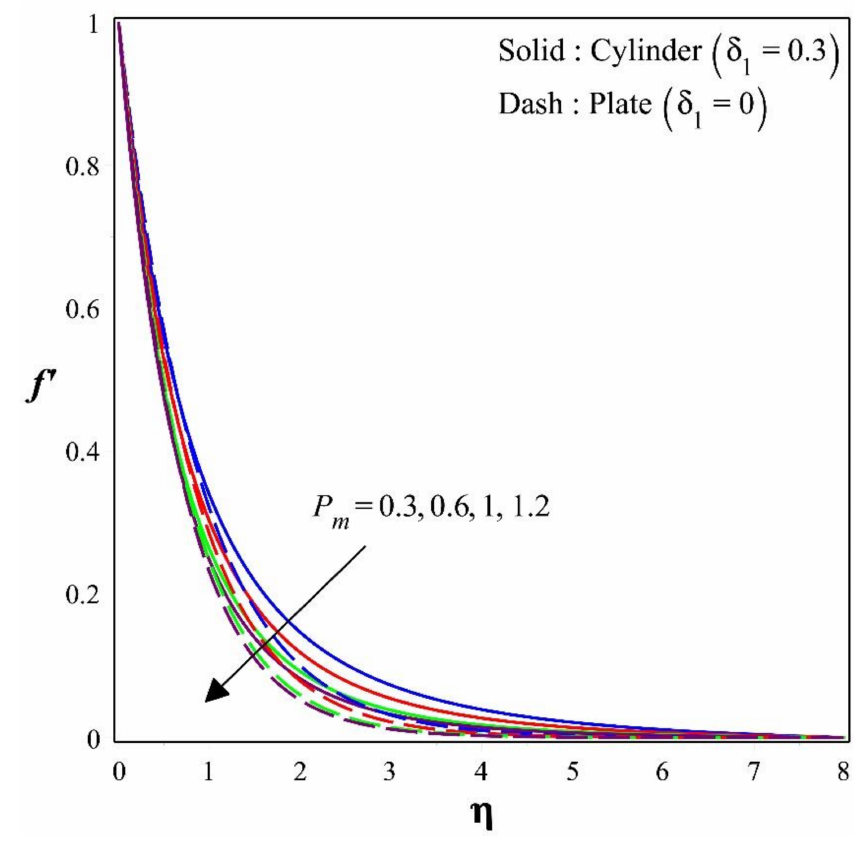
Figure 2. The role of porosity parameter on velocity profile (keeping γ 1 = 0.1, ζ = 30 0 , φ 1 = φ 2 = φ = 0.01& H = 3 SS